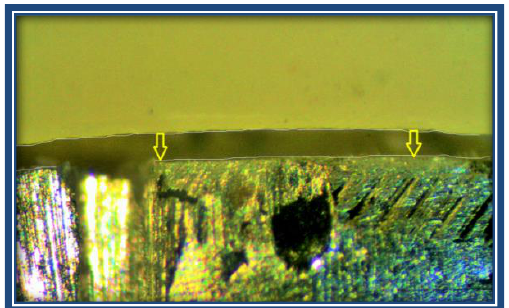
Figure 5: Two points for marginal gap measurement with Image